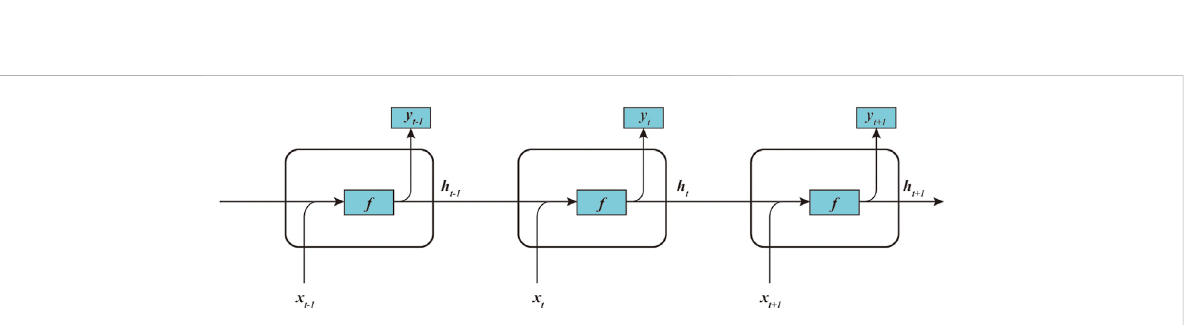
FIGURE 2 RNN structure. Each structuralunit accepts both theinput data andthehidden state of theprevious unit, and outputs thepredictedvalueatthe current moment.